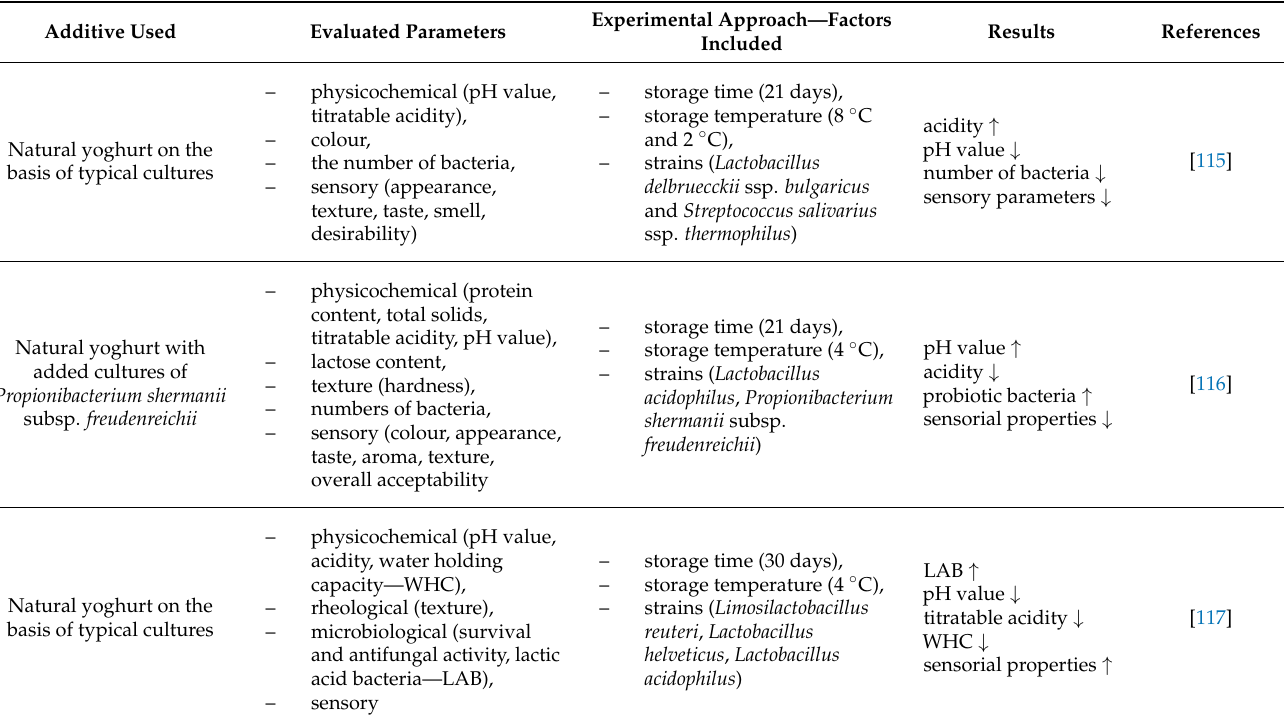
Table 5. Selected studies on the plain (natural)